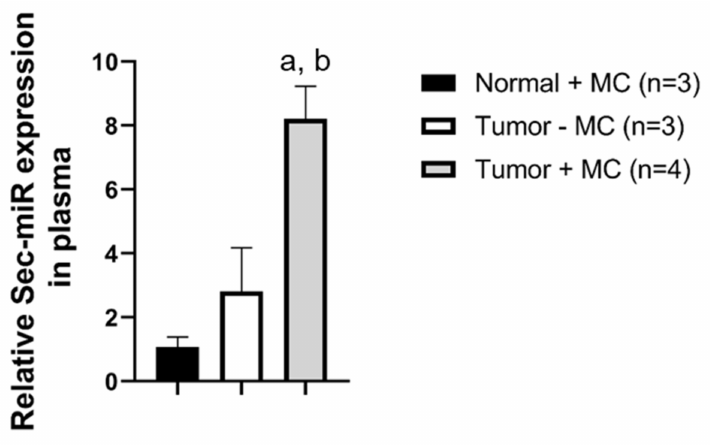
Figure 4. Systemic delivery of tumor-specific Sec-miR MC allows the identification of tumor-bearing subjects. After the average tumor size reached 150 mm 3 , tumor-specific Sec-miR MCs (40 µ g, N/P = 8) were injected systemically to tumor-bearing mice (Tumor + MC) and healthy normal mice (Normal + MC). Normal (tumor-free) mice received MCs (Normal + MC), and tumor-bearing mice that did not receive MCs (Tumor − MC) were served as control groups. Sec-miR expressions in blood were measured on day 2 after MC injection. Sec-miR expressions significantly increased in blood compared to Normal + MC and Tumor − MC groups. a, compared to Normal + MC, p < 0.01; b, compared to Tumor-MC, p <